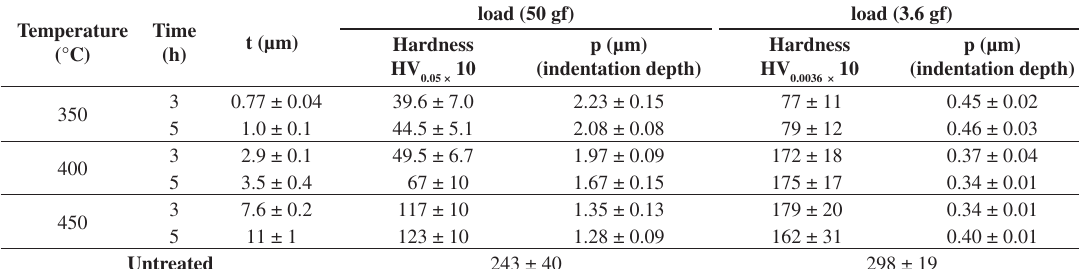
Table 1. Some characteristics and properties of the nitrided layers: nitrided layer thickness ( t ), mean value of hardness and mean value of penetration depth ( p ) of the Vickers indenter. Temperature